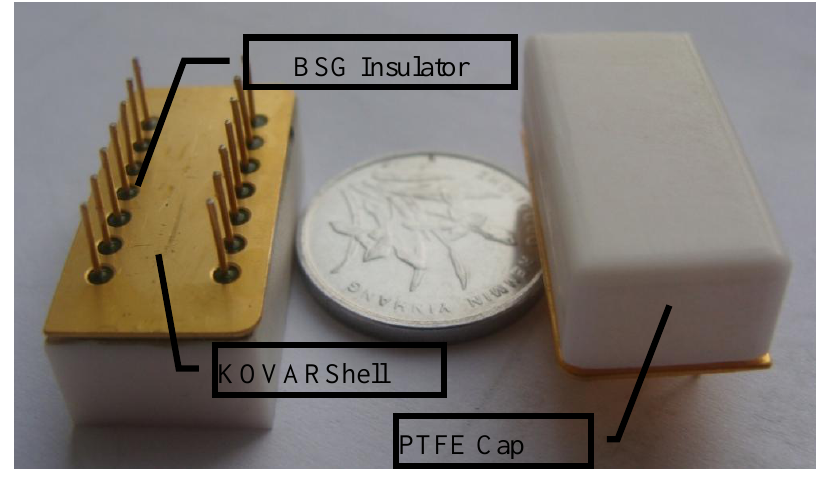
Figure 1. Photograph of an EFMS package with PTFE cap.